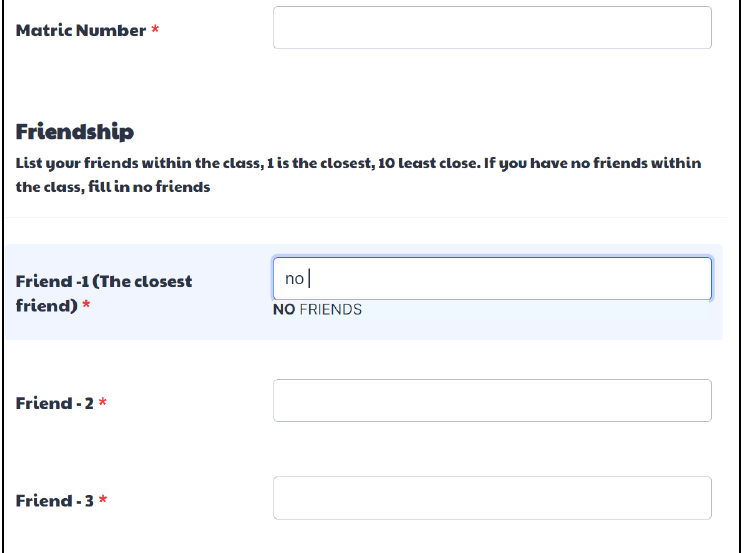
Figure 1. An English version of the distributed online Malay language questionnaire with the autocomplete feature in Jotform.